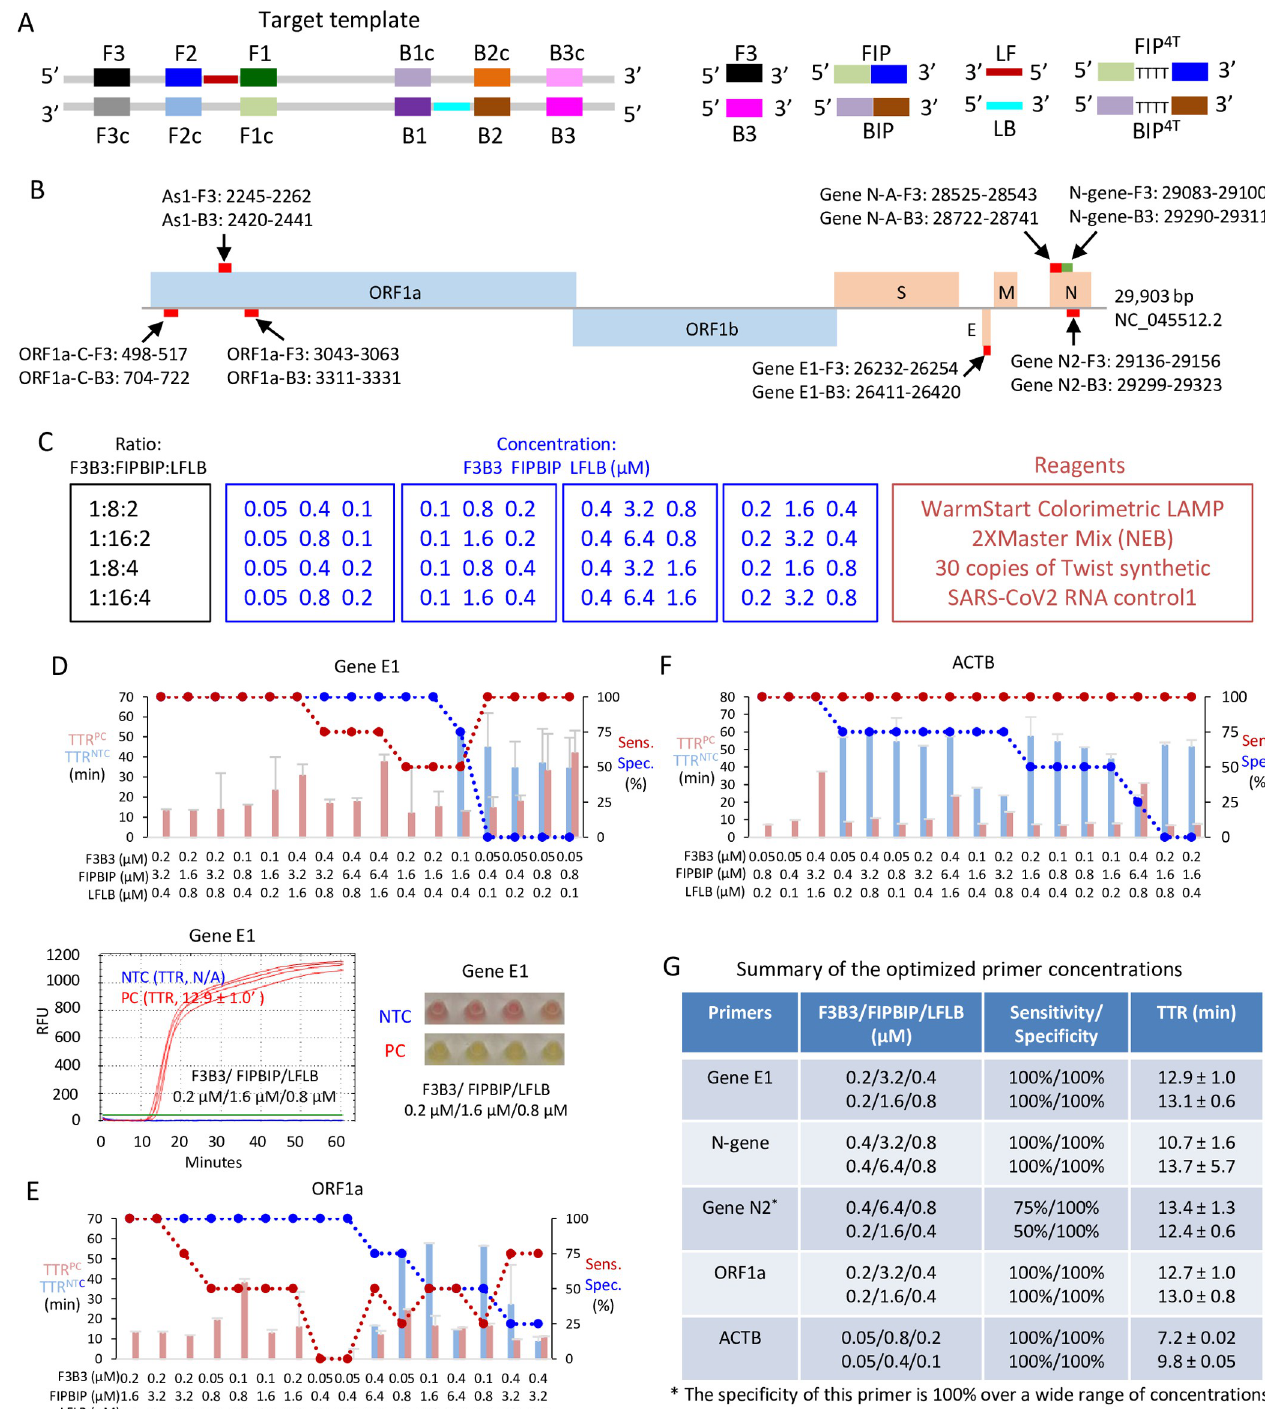
Fig 1. Screening primer performance at a low copy number of SARS-CoV-2 RNA. (A) A schematic showing a DNA template amplified by LAMP and the primers targeted to the regions in the template. (B) Location of the 7 target regions for the 14 primer sets in the SARS-CoV-2 genome (NC_045512.2, [34]). The indicated target region is that amplified by the outer F3 and B3 primers. (C) Matrix of test conditions. Each primer set was tested with the indicated primer molar ratio (black), and primer concentrations (blue). A total of 16 conditions were tested for each of the 14 primer sets, with 4 replicates per condition. Other reaction reagents are indicated in red. (D) Screening results for primer Gene E1. Top panel: For the indicated primer mixes (X-axis), red and blue bars indicate TTR using 30 copies of positive control SARS-CoV-2 RNA (TTR PC ) or no template (TTR NTC ), respectively. Red and blue circles indicate sensitivity and